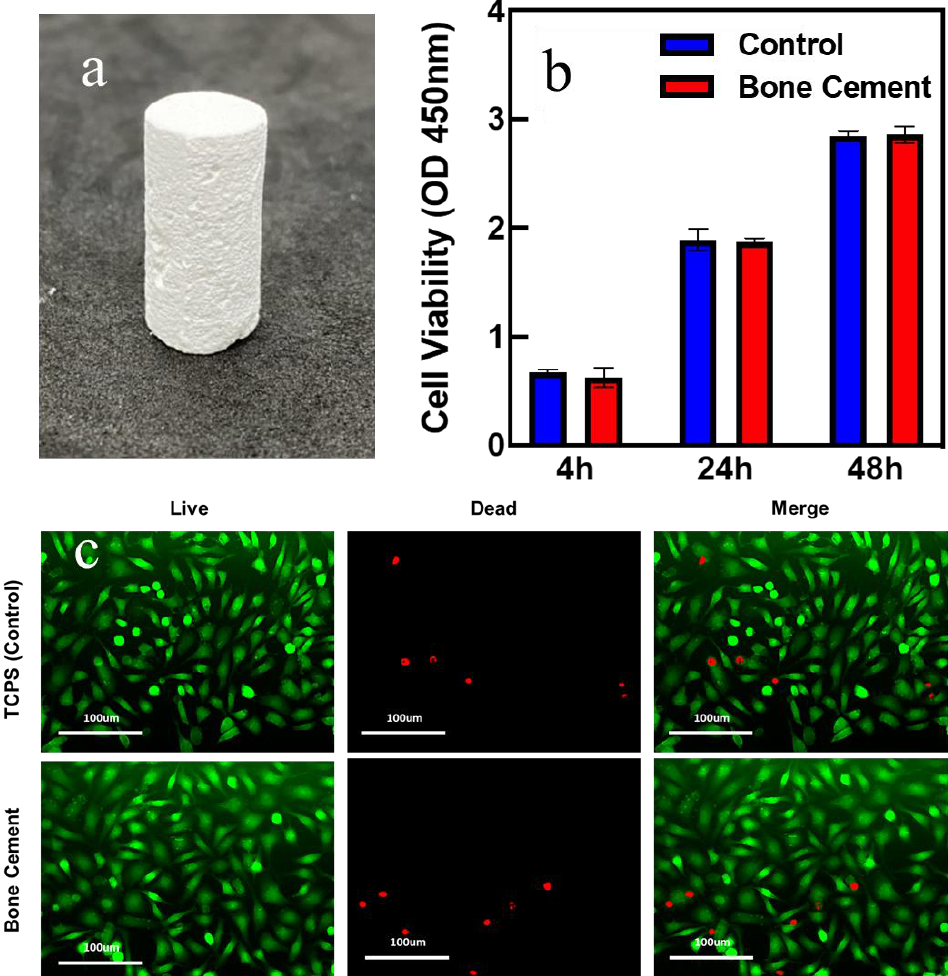
Figure 6. ( a ) Image of the hardened β -TCP bone cement. ( b ) The cell viability of the bone cement and control group. ( c ) Live(green)/dead(red) assay of the bone cement and control group.